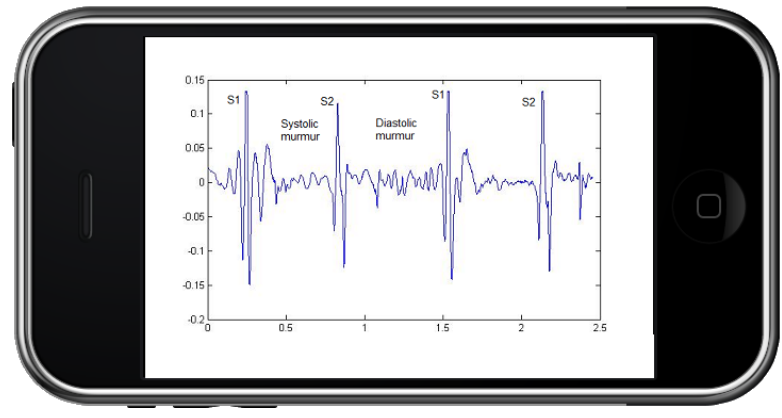
Figure 1. An illustration of the Phonocardiogram with its